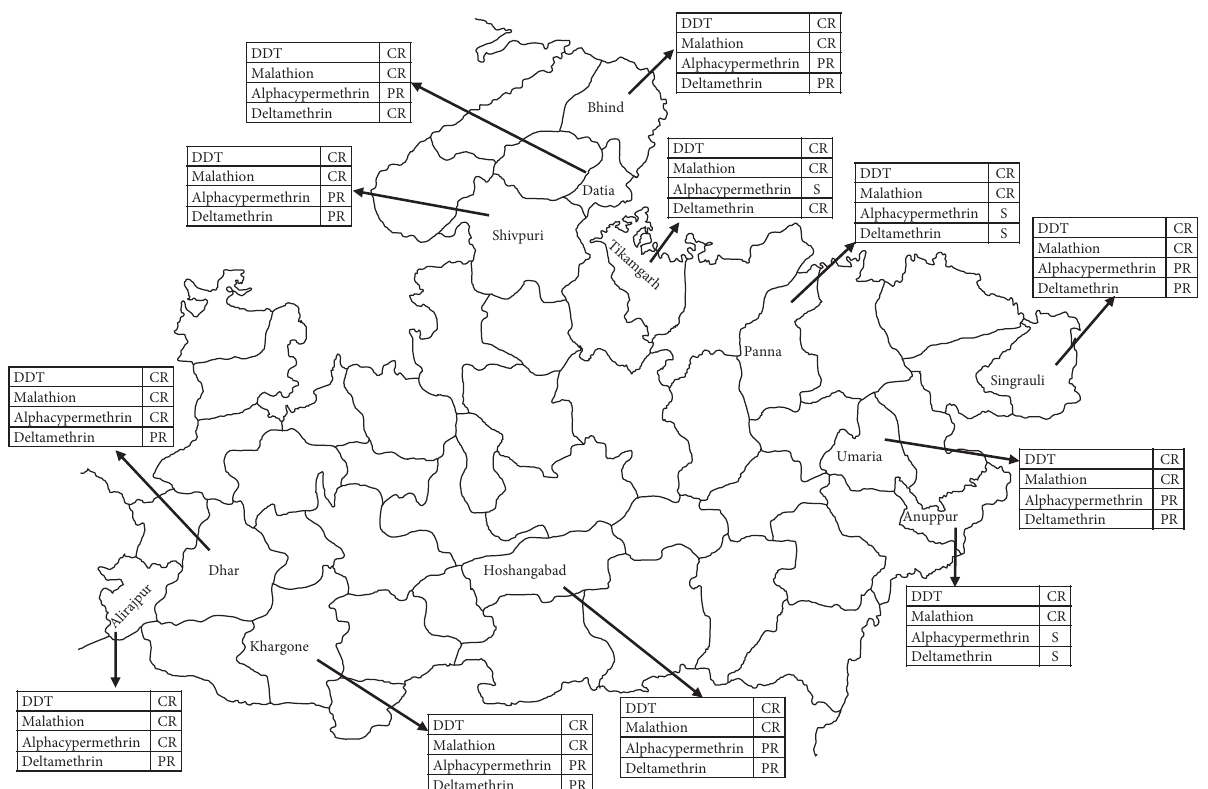
Figure 1: Map of Madhya Pradesh showing study districts and insecticide susceptibility status of An. culicifacies.